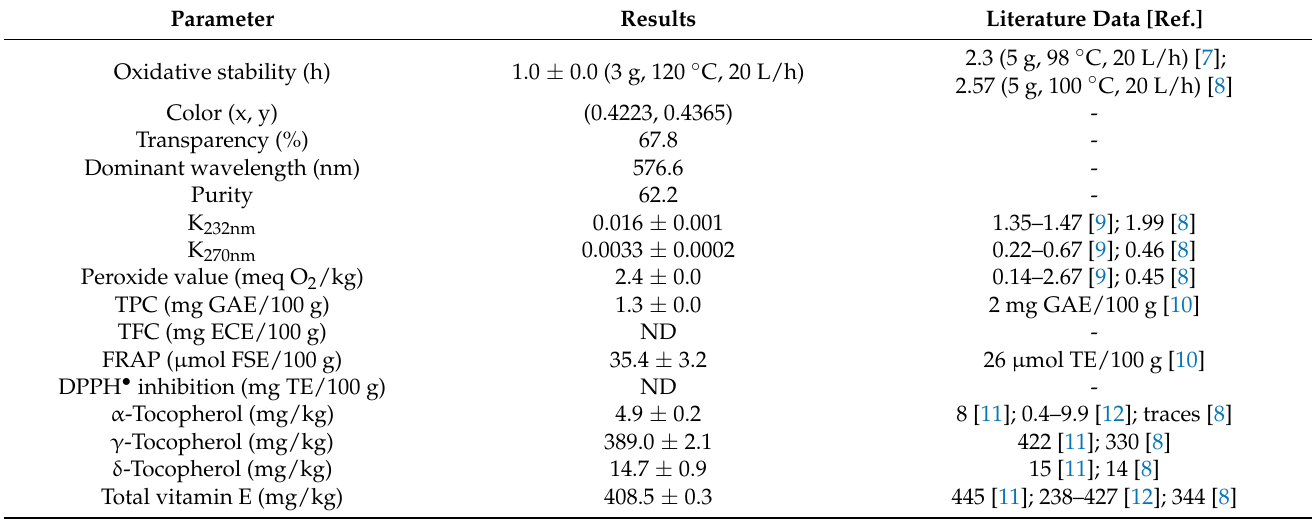
Table 1. Chemical analysis of cold-pressed chia oil and literature